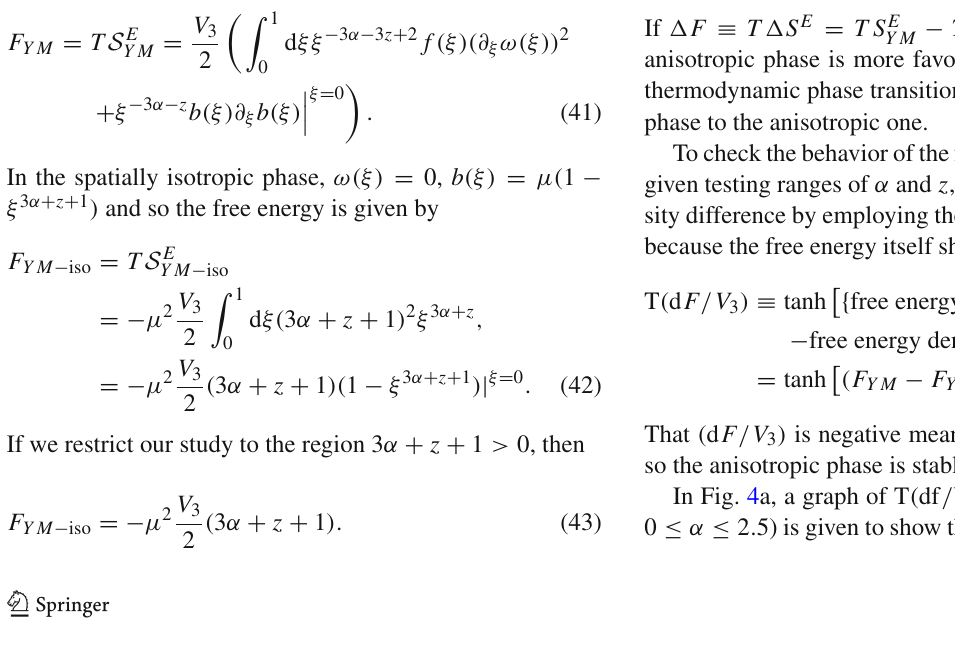
Fig. 4 The difference of free energy density between the anisotropic state ( ω (cid:16)= 0) and the isotropic state ( ω = 0) for the fixed values of z in a and α in